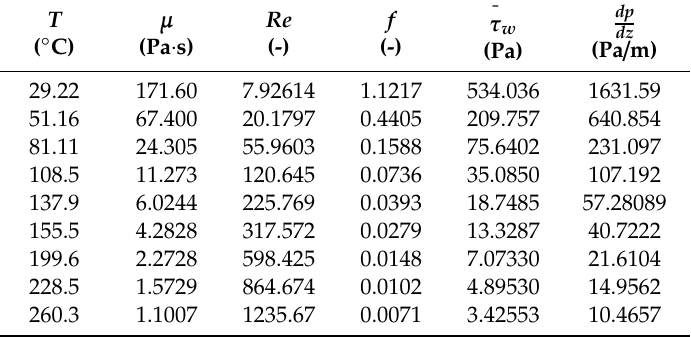
Table 11. Values of the fluid dynamic parameters obtained in the simulations with β = 0.06 and N =